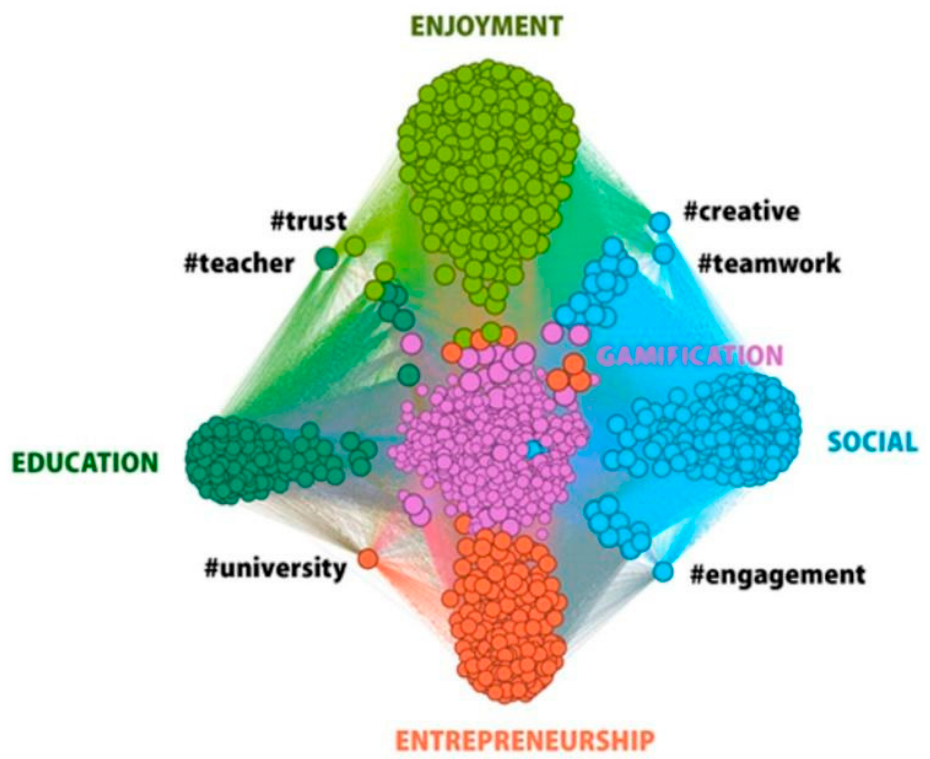
Figure 5. Network hashtag layout based on the ForceAtlas 2 algorithm (1425 hashtags and 195,993 edges). Source: “Education and Business as a Key Topics at the Instagram Posts in the Area of Gamification” [20].